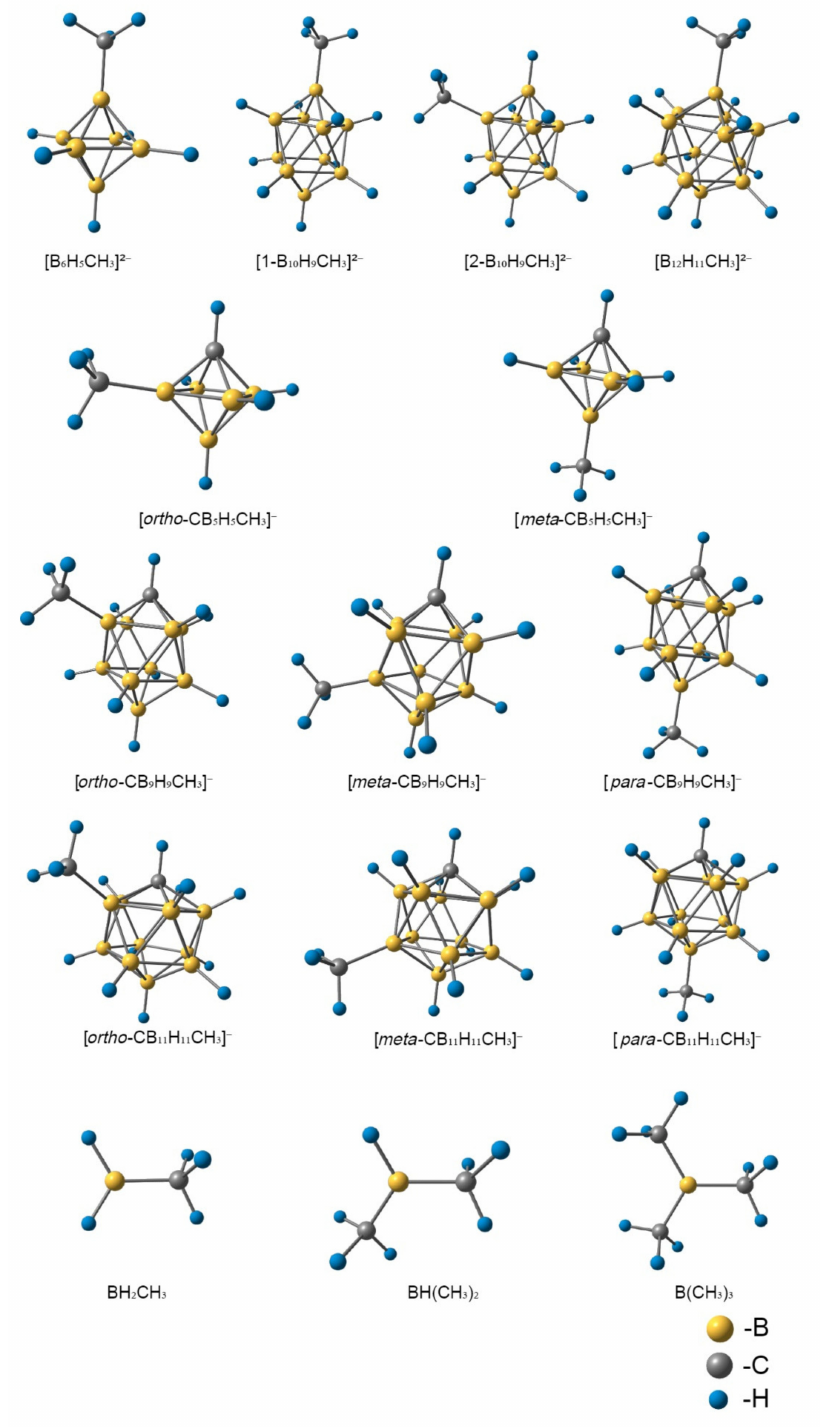
Figure 1. Optimised structures of closo-borate anions of the general form [B n H n − 1 CH 3 ] 2 − (n = 6,